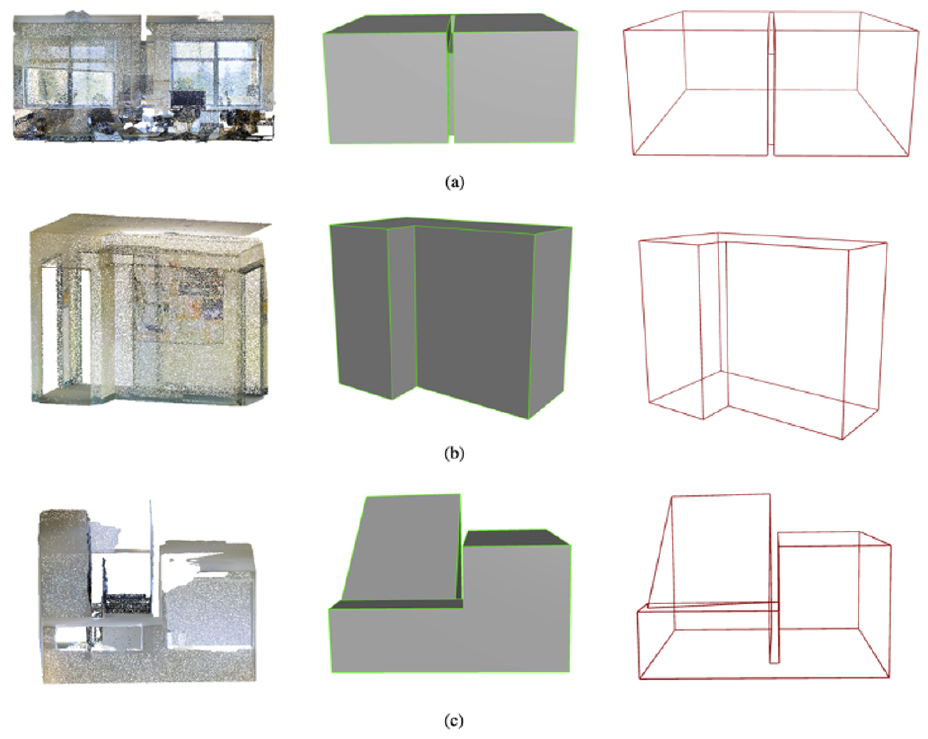
Figure 8. Zoom-in view of irregular shape indoor environment in Area 6/2D-3D-S: ( a ) Office 8, which has an small-structured uneven ceiling height; ( b ) hallway 3, which is in irregular shape; and ( c ) slanted walls in Hallway